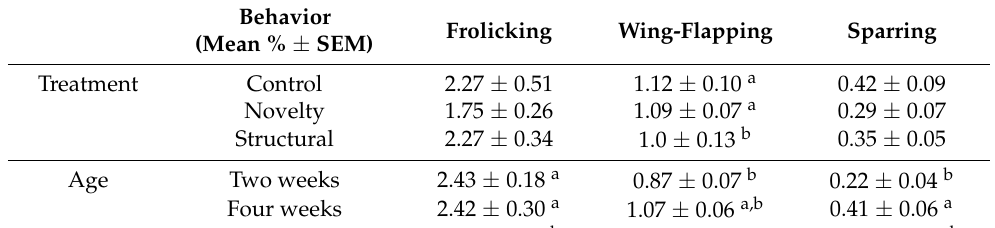
Table 2. The mean ( ± SEM) percentages of chicks that performed each play behavior (frolicking, wing-flapping and sparring) across three rearing treatments (control, novelty, structural) at three different observation age points (2, 4, 6 weeks). a,b Dissimilar superscript letters indicate differences across rearing treatments or across age. Raw means are presented with analyses conducted on transformed data.